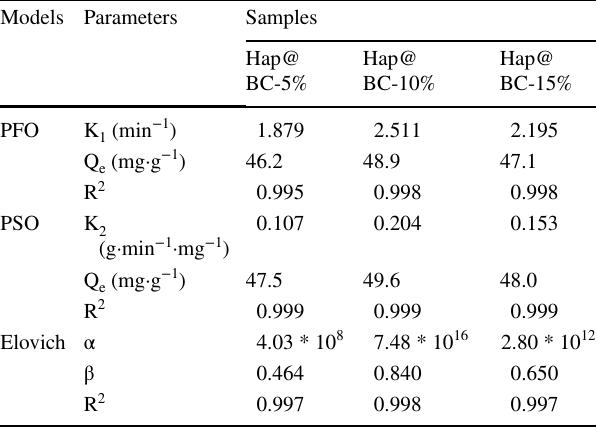
Table 1 Kinetic parameters of U(VI) adsorption on